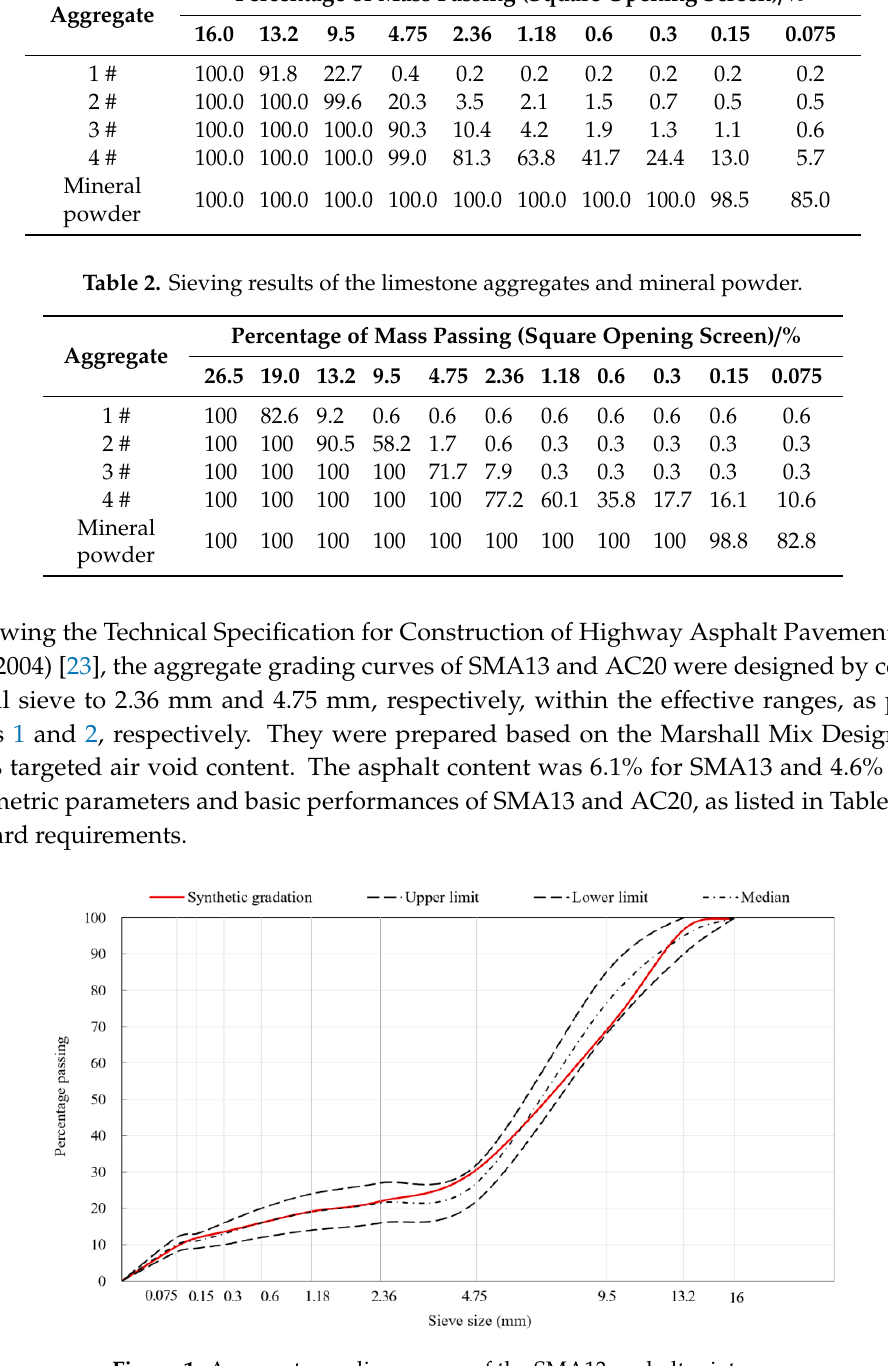
Table 1. Sieving results of the basalt aggregates and mineral powder.